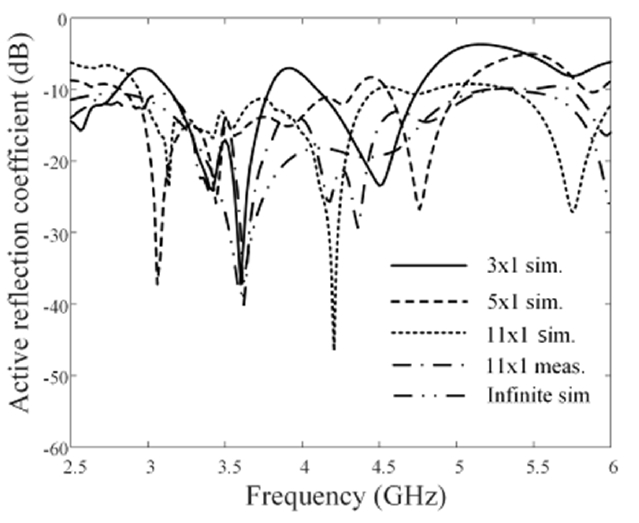
Figure 8. Comparisons of the simulated and measured ARCs according to the number of array elements.